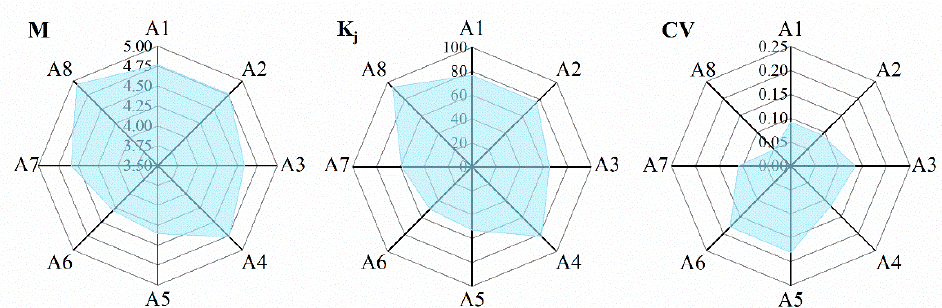
Figure 3. Coordination comparison of emergency food supply domains. Emergency food demand —